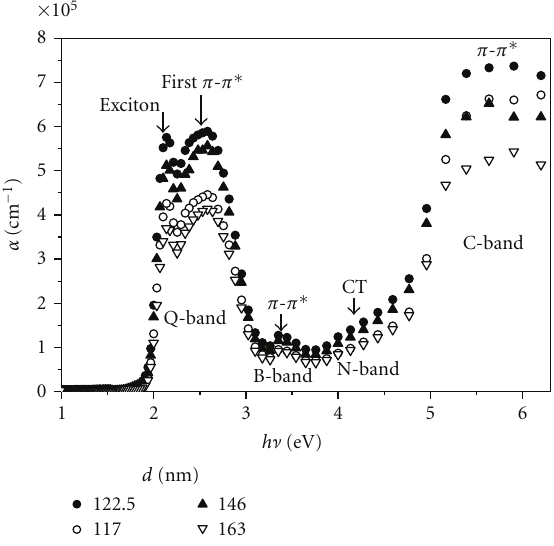
Figure 8: Optical absorption spectra of PTCDI thin